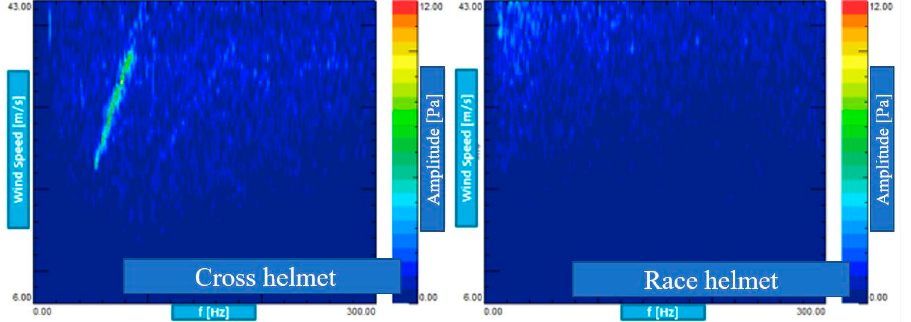
Figure 7. Comparison between cross helmet and racing helmet.